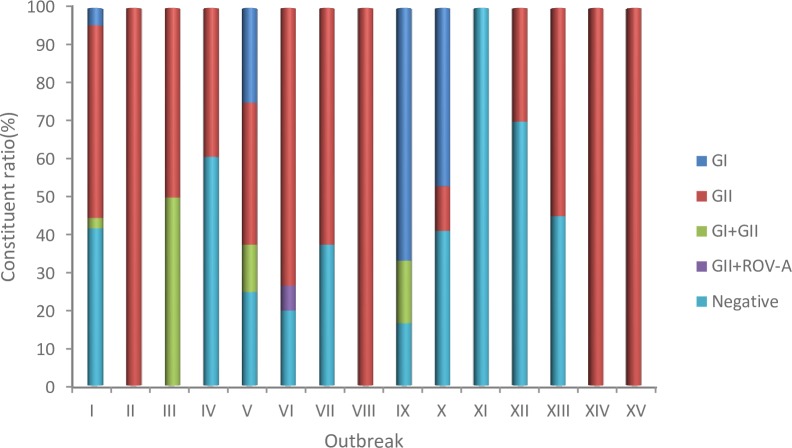
Virological screening of 15 outbreaks of acute gastroenteritis in Jinan, China, 2015–2017.“Negative” indicates that the specimens from the outbreaks were negative for NoV, RoV, SaV, Ast, and ADV.